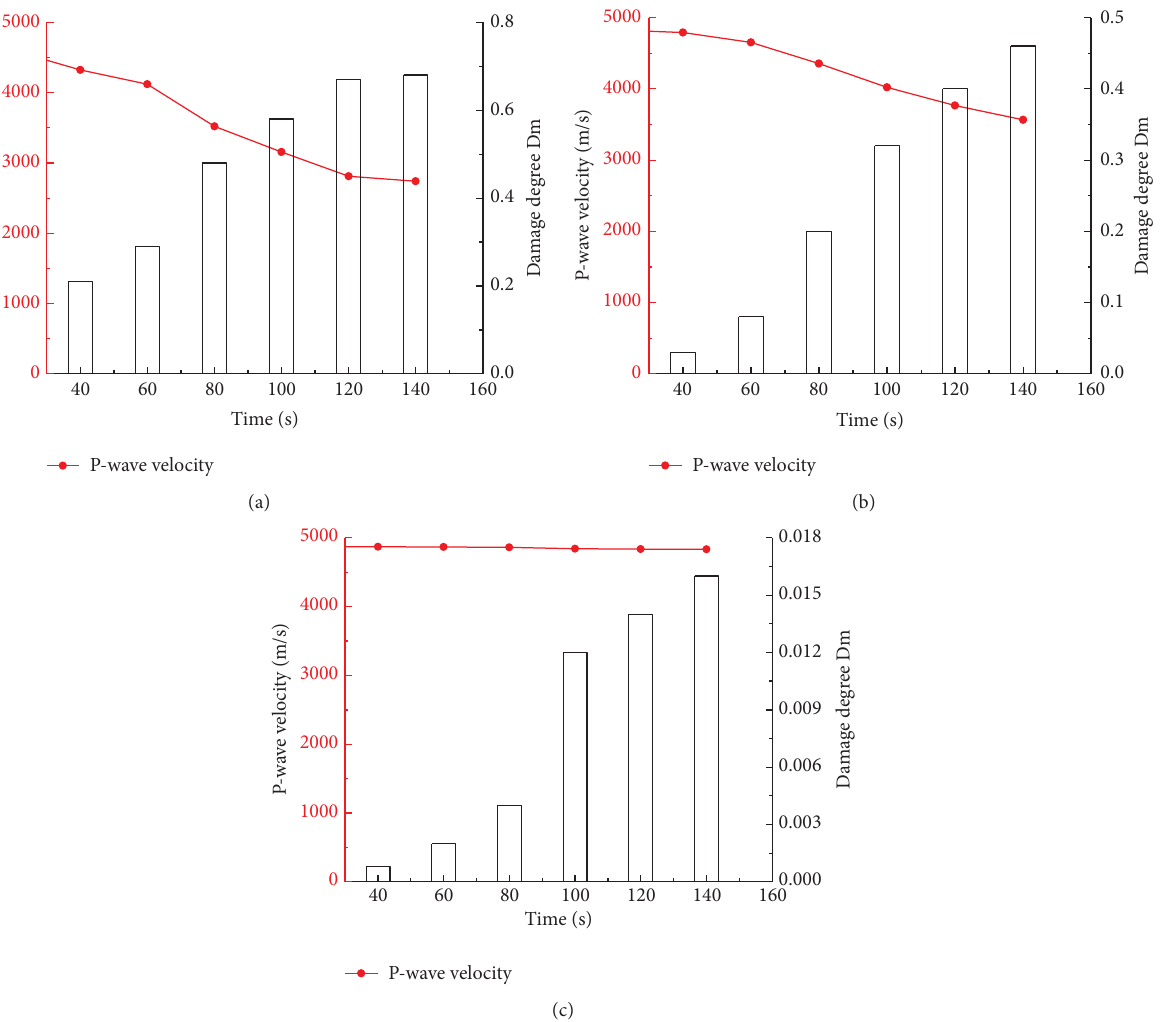
Figure 14: P-wave velocities and damage parameters at different locations of the rock specimen after various ultrasonic vibration durations.